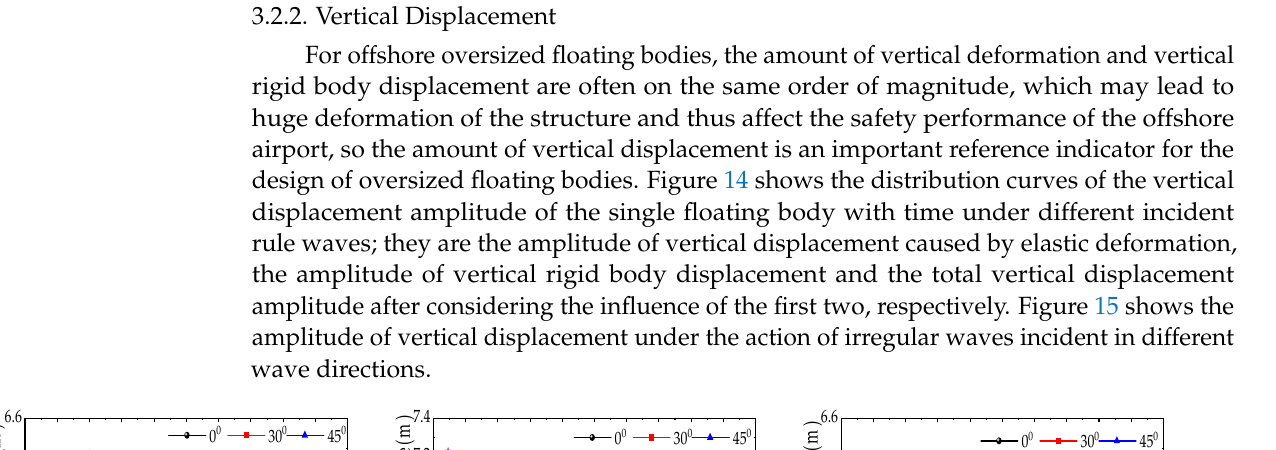
Figure 13. Von Mises stress variation clouds under different wave directions. ( a ) t = 40 s; ( b ) t = 70 s; ( c ) t = 140 s.